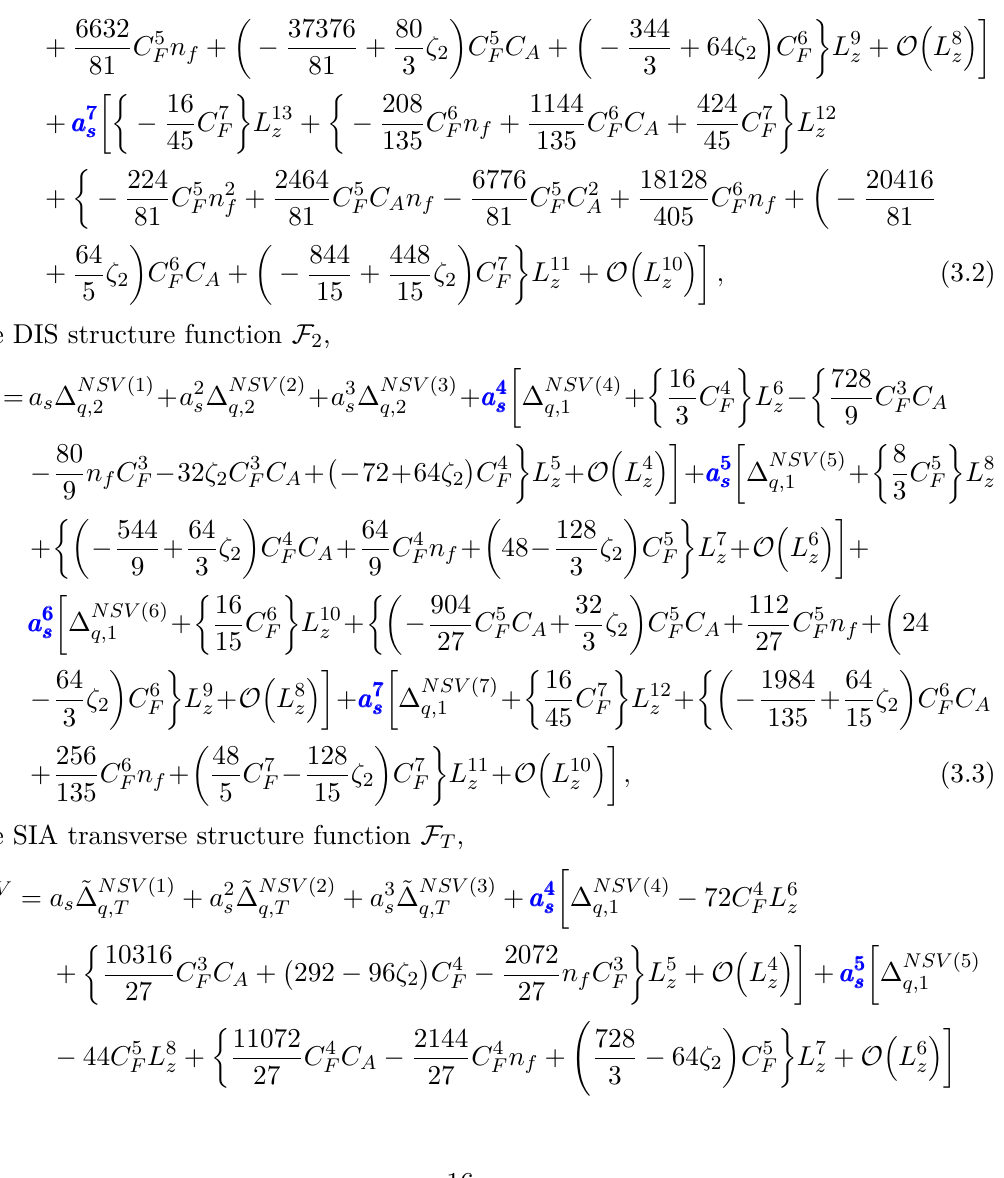
Table 1 . Towers of Distributions ( D i ) and NSV logarithms ( log i (1 − z ) ) that can be predicted for ∆ c using eq. (2.8). Here Ψ ( i ) c and ∆ ( i ) c denotes Ψ c and ∆ c at order a i L i denotes log i (1 − z ) z